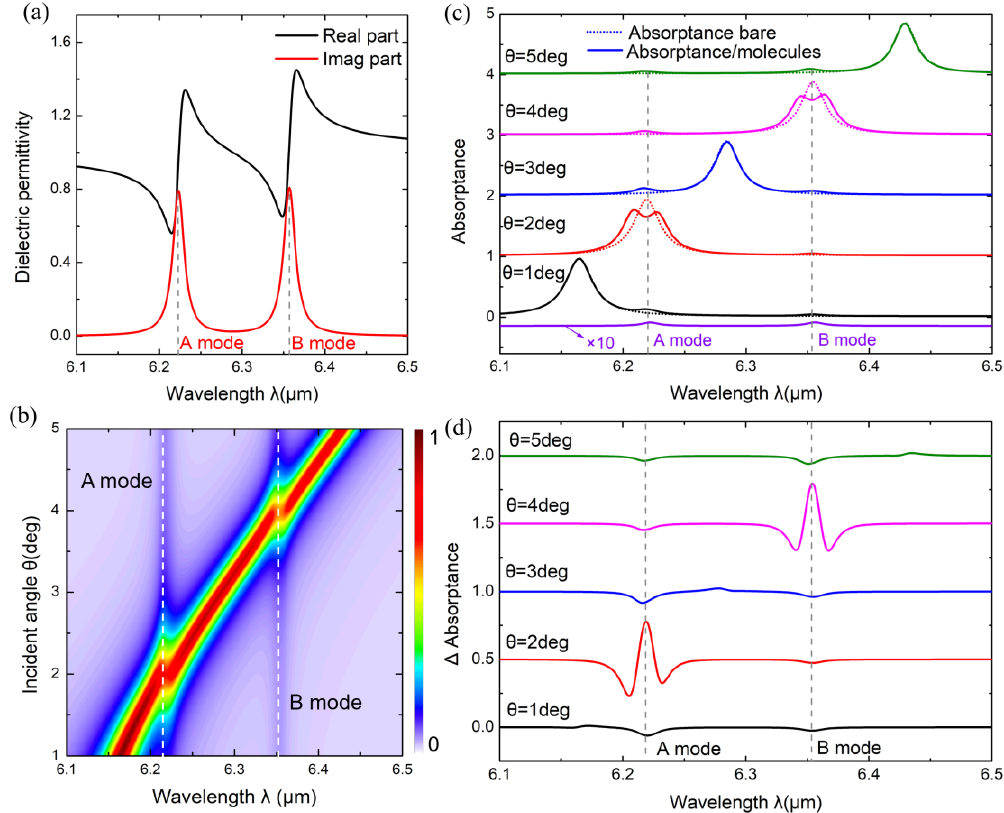
Figure 6. ( a ) The dielectric permittivity of the molecular film with two vibrational modes at 6.225 µ m and 6.355 µ m when N A = N B = 0.1 mol m − 3 , γ A = γ B = 8 × 10 11 rad / s. ( b ) Absorptance map of the dielectric-metal absorber covered with molecules film with di ff erent incident angle. ( c ) Absorption spectra of absorber covered with and without molecules film in di ff erent incident angle. ( d ) Delta absorptance of absorber covered with molecules film in di ff erent incident angle.